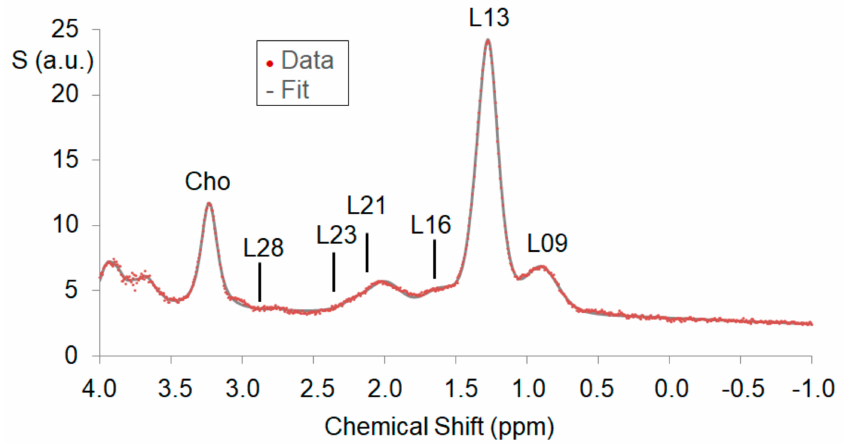
Figure 4. Example water suppressed liver spectra with main peaks marked: a methylene (CH2) peak at 1.3 ppm, a methyl (CH3) peak at 0.9 ppm, α -olefinic and α -carboxyl peaks at 2.1 ppm, a diacyl peak at 2.8 ppm, and a choline peak at 3.2 ppm. The model fit (thin underlying grey line) of the single components fits the measured data (red dots) very well.